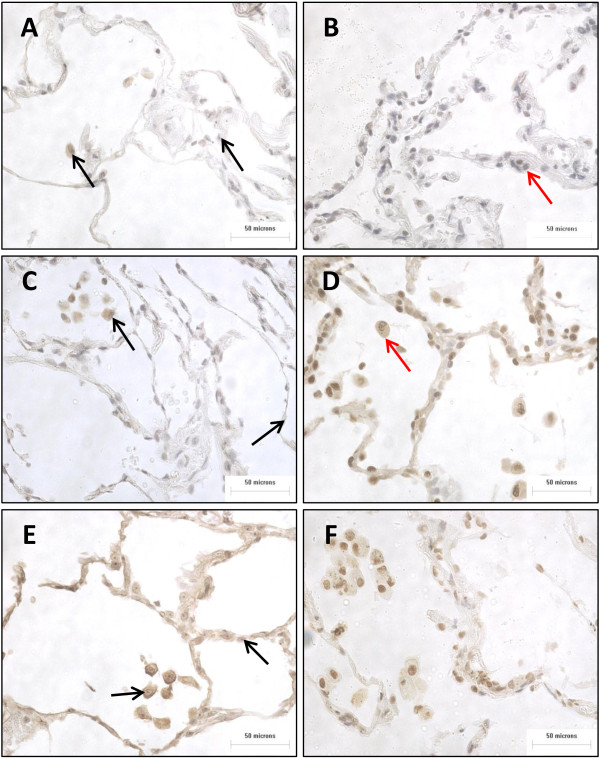
Representative images of LXRα and LXRβ expression in alveolar epithelium and alveolar macrophages. The distribution of LXRα (A, C, and E) and LXRβ (B, D, and F) in the alveolar wall (red arrow in B) and in alveolar macrophages (red arrow in D) present in lung sections of NS (A-B), S (C-D) and COPD patients (E-F). Positive LXRα stain indicated by black arrow.